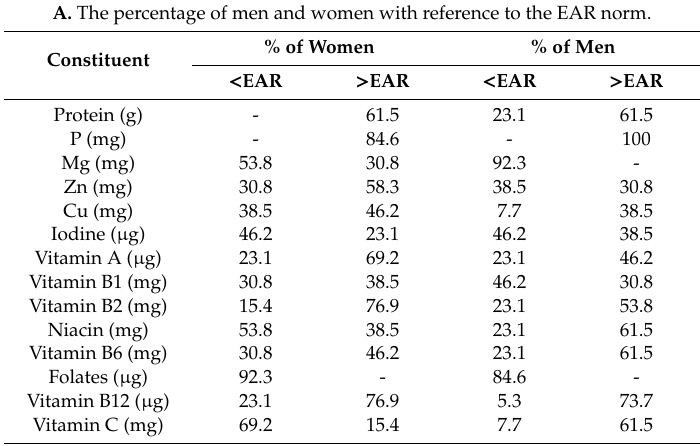
Table 4. The percentage of men and women with reference to the norms [%]. A. The percentage of men and women with reference to the EAR norm.